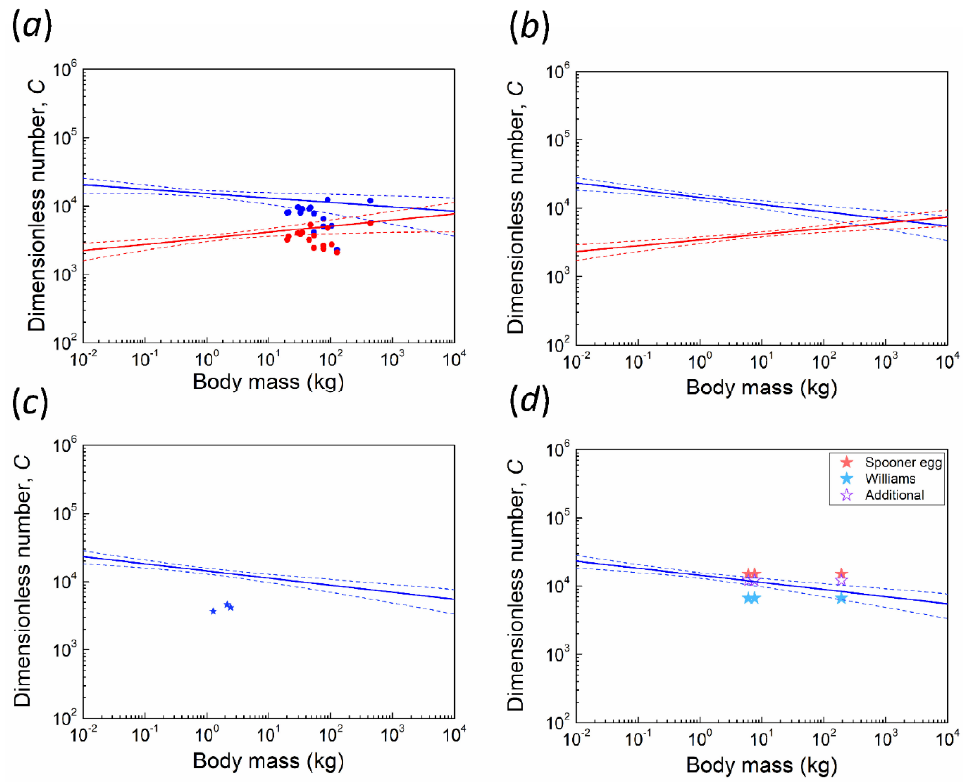
Figure 3. Allometries between body mass (BM) and the dimensionless number C (blue) and critical C (red) on a double logarithmic scale. Dash lines: 95% confidence interval. ( a ) two fitting lines of data from Juang et al. [3] with data points of 15 ratite species (excluding kiwi, see discussion). ( b ) new fitting lines combined with data points of 15 ratite species. ( c ) the new fitting line of C with three data points of kiwi. ( d ) the new fitting line of C with six data points of PGOM. Williams’ egg is marked as a light blue star, whereas the Spooner egg is marked as a red star. Purple hollow stars indicate our additional specimens. Points of larger body mass represent Genyornis newtoni , whereas smaller points represent two extinct megapodes, respectively.